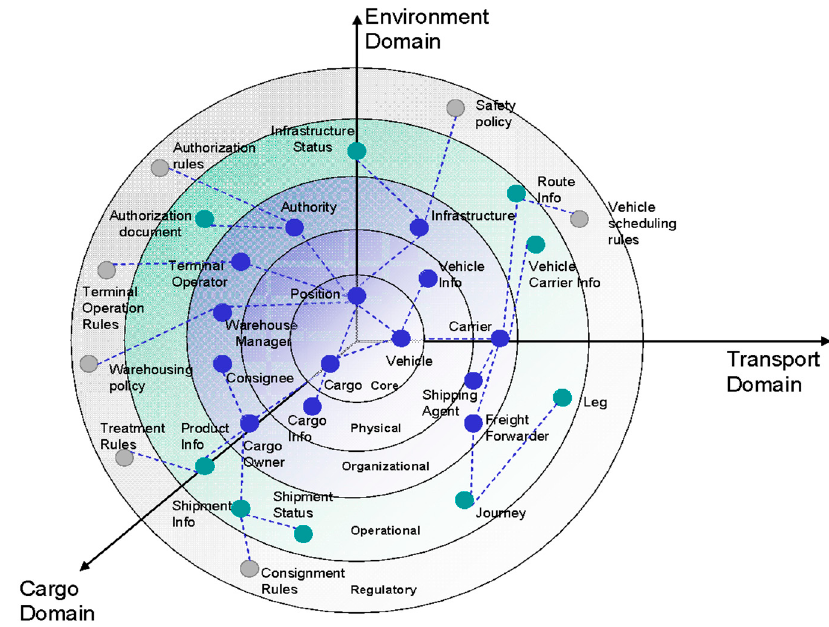
Figure 3. Ontology model for cargo